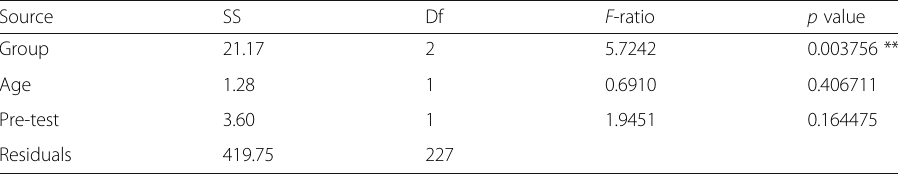
Table 12 Analysis of variance (ANOVA) type II result for immediate test and pre-test Source